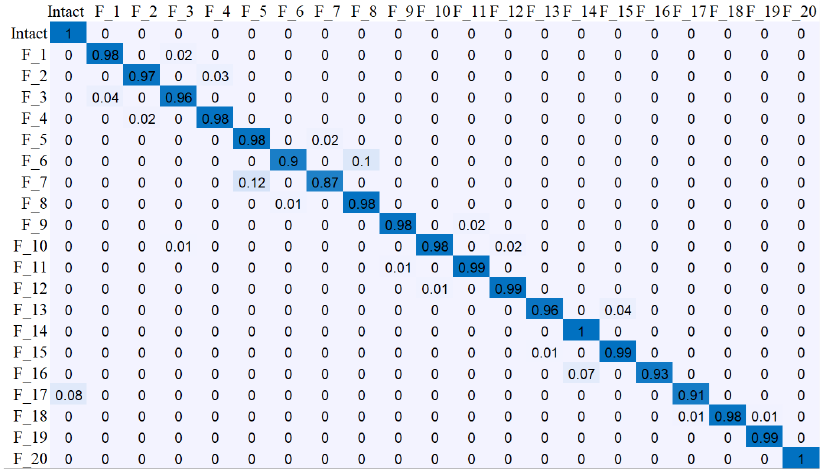
Figure 15. Failure detected location when there are 5 sensors at points 2, 4, 5, 6, and 8 (Accuracy: 96.7%).